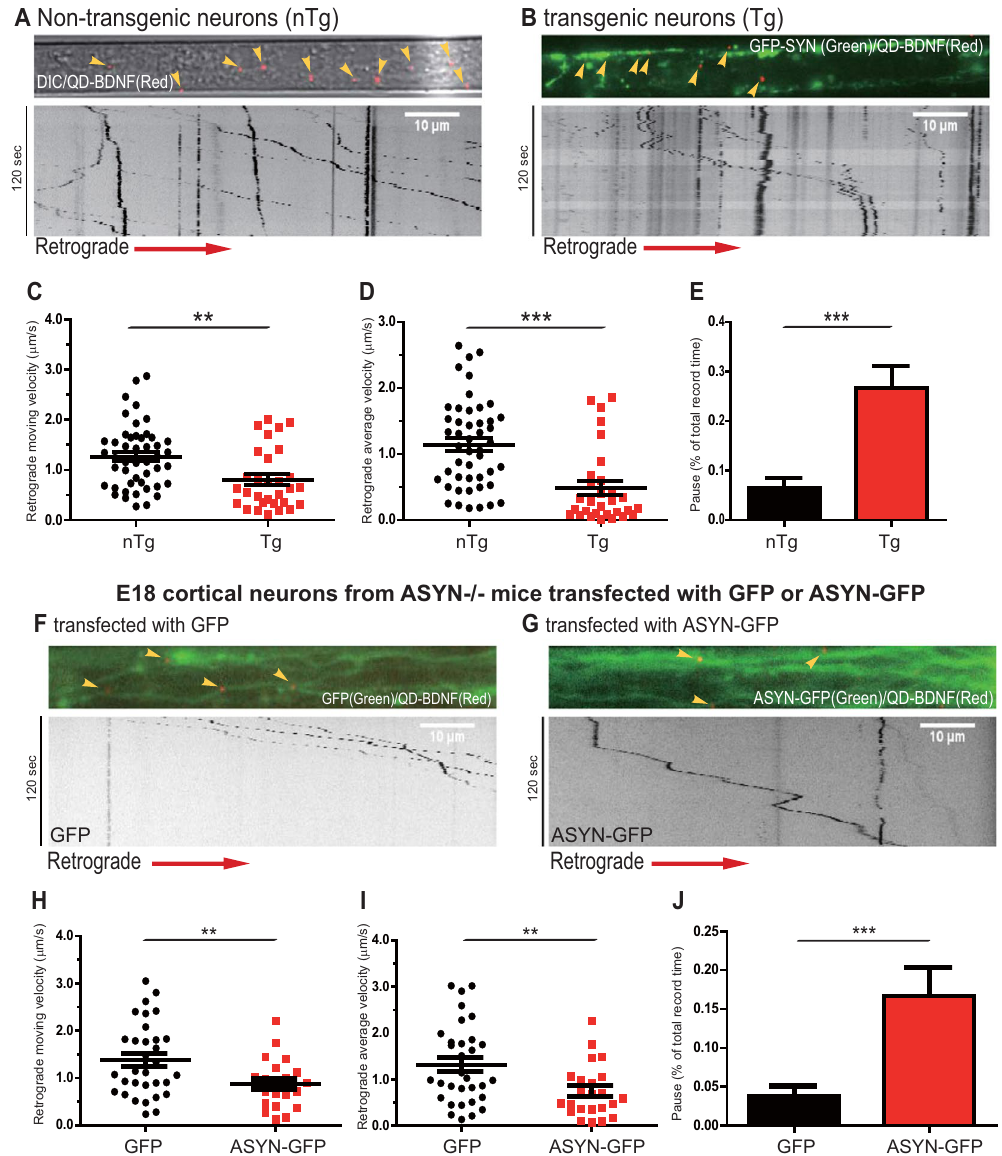
Figure 1. Expression of GFP-ASYN induced retrograde axonal transport deficits of BDNF in E18 cortical neurons. E18 cortical neurons from Line 78 (PDGF- β -ASYN-GFP) mouse embryos were dissected and cultured in microfluidic chambers as described in Materials and Methods. At DIV7, neurons were deprived of BDNF for 3–4 hrs, QD-BDNF (0.2 nM final concentration) was added to the axonal chambers. Axonal transport of QD-BDNF was captured by live imaging. Kymographs were generated from time-lapsed image series. Representative image of QD-BDNF within axons of non-transgenic ( A ) and transgenic neurons ( B ) are shown. Axonal transport parameters: the retrograde moving velocity ( C ), average velocity ( D ) and pausing time ( E ) are quantitated and presented. Data were obtained from 10 non-transgenic neurons and 20 GFP-positive transgenic neurons. In F–J , E18 cortical neurons from ASYN knockout ( − / − ) mice were dissected and cultured. At DIV4, cultures were transfected with either GFP or ASYN-GFP and BDNF transport assays were carried out as described above. Representative images of transfected axons and kymographs are shown: F for GFP; G for ASYN-GFP. The retrograde moving velocity ( H ), average velocity ( I ) and pausing time ( J ) were quantitated and presented. Data were obtained from 15 GFP-expressing neurons and 15 GFP-ASYN-expressing neurons. All data are analyzed using Prism Graphpad 6.0. The p values were obtained using student t-test. p < 0.05 ( ** ); p < 0.01 ( *** ); n.s. =